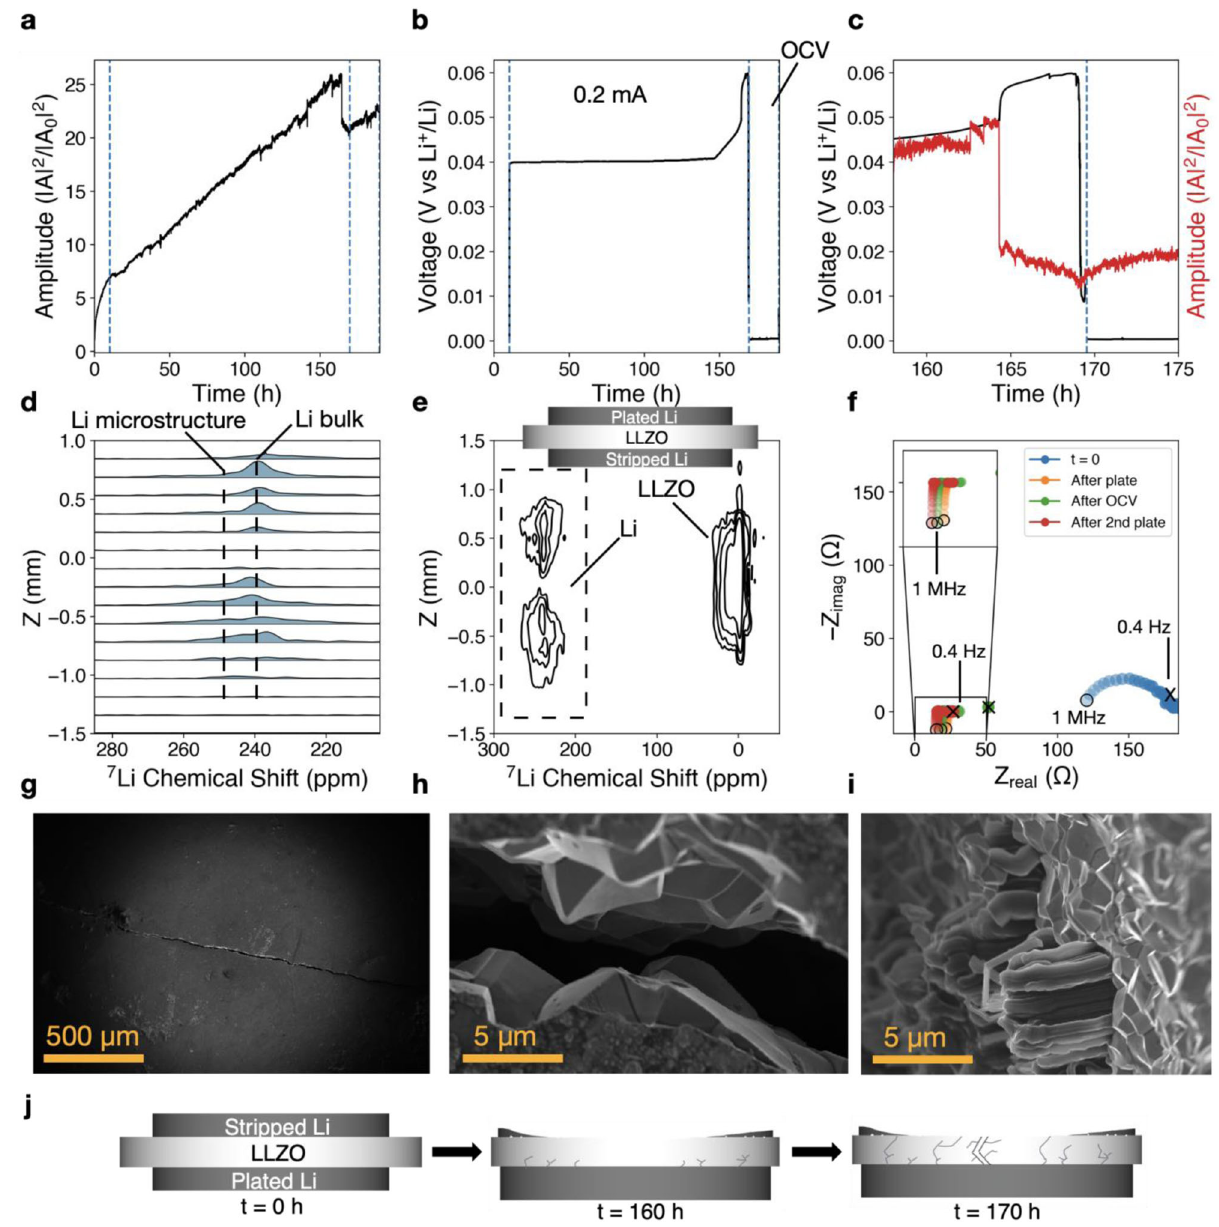
Fig. 4 Lithium metal – LLZO interface at 13 MPa. Polarization test of Li (s) – LLZO interface at 13 MPa stack pressure conducted in a Li/LLZO/Li cell. After a few hours of initial mechanical equilibration, 0.2 mA/cm 2 is applied galvanostatically until the voltage cutoff of 5 V, followed by a 25 h OCV rest step, a second polarization step in the same direction, and a second OCV rest step. a Normalized acoustic amplitude. b Voltage showing increase in overpotential until an electrochemical short at ~60 mV vs Li + /Li ( t ~ 169 h) during the galvanostatic current step of 0.2 mA/cm 2 . Vertical guidelines (blue dotted lines) are shown as a visual aid to delineate start and stop of galvanostatic current. c Zoomed in region of electrochemical shorting event at around t = 169 h which is accompanied by a sudden attenuation of acoustic amplitude. d 1D slices of ex situ 7 Li CSI highlighting the lithium metal peak between 200 and 280 ppm, as indicated by the dashed region in e . e Ex situ 7 Li CSI contour plot showing formation of lithium microstructures at the Li (s) – LLZO interface for both electrodes, and the presence of bulk lithium metal (240 ppm) in the electrolyte. f Nyquist plot from potentiostatic electrochemical impedance spectroscopy conducted during initial OCV, after galvanostatic current to the voltage cutoff, after the 25 h OCV, and after the second plating step to the voltage cutoff. The open circle indicates the high-frequency start point (1 MHz), and the cross indicates the low-frequency end point (0.4 Hz). g SEM image of center of LLZO on the stripped lithium side (in this case, most of the existing lithium foil was plated through the electrolyte resulting in an almost-bare LLZO surface), showing a large crack. h High-resolution SEM image of crack which reveals the polycrystalline grains of LLZO. i High-resolution SEM image showing the presence of lithium protrusions from polycrystalline grain boundaries along the exposed crack, with protrusions oriented parallel to the electrode (instead of protruding through the electrolyte). j Simpli fi ed cartoon illustration of interface behavior implied by the experimental data; not drawn to scale.